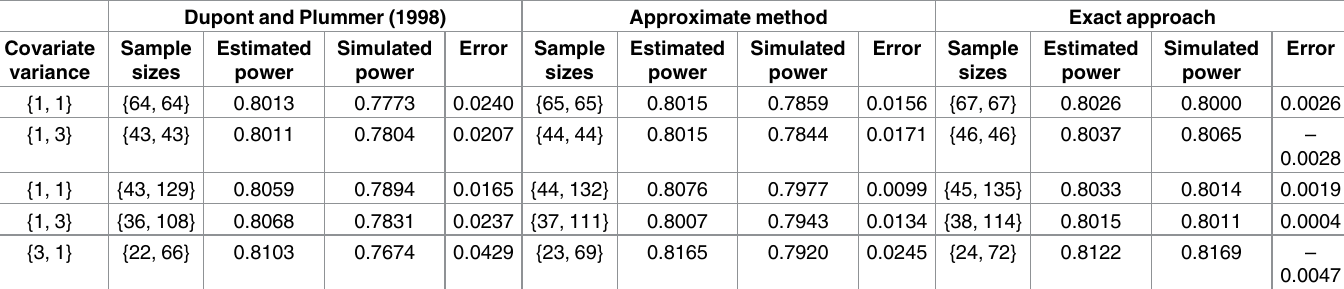
Table 1. Computed sample size, estimated power, and simulated power when δ = 0.50, Type I error α = 0.05, and nominal power 1 – β = 0.80.